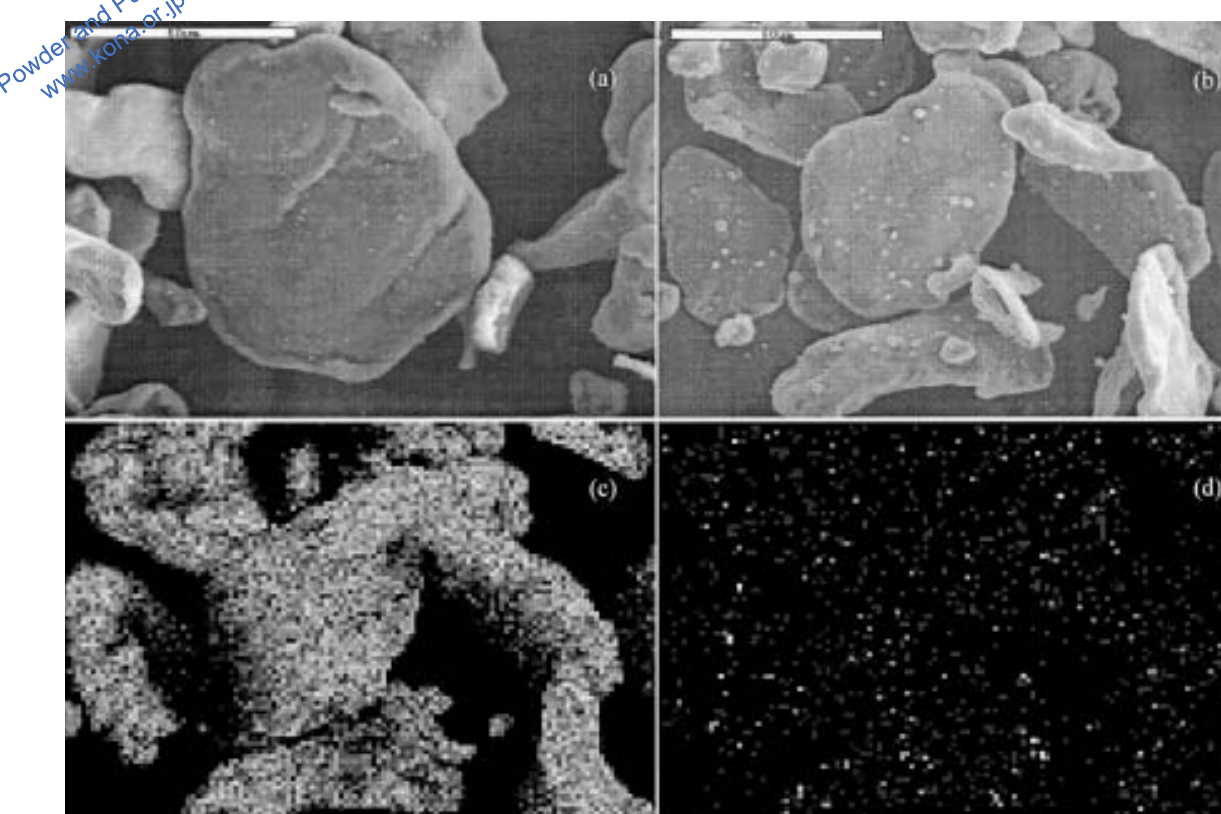
Fig. 4 SEM images of (a) pure Mg (44 µ m) processed for 90 minutes and (b) Mg-2 at % Ni processed for 90 minutes; EDX mapping of (c) Mg and (d) Ni for Mg-2 at %